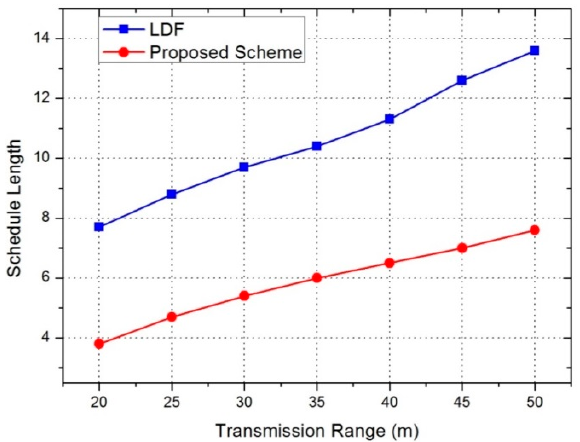
Figure 9. Simulation result on schedule length.